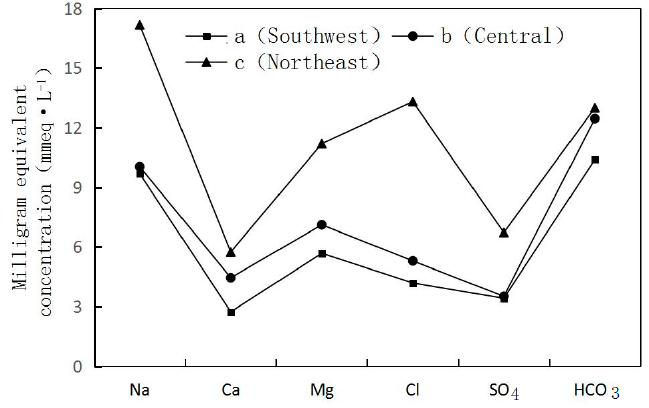
Figure 4. Sketch map of horizontal hydrochemical zonation of phreatic water in the study area.